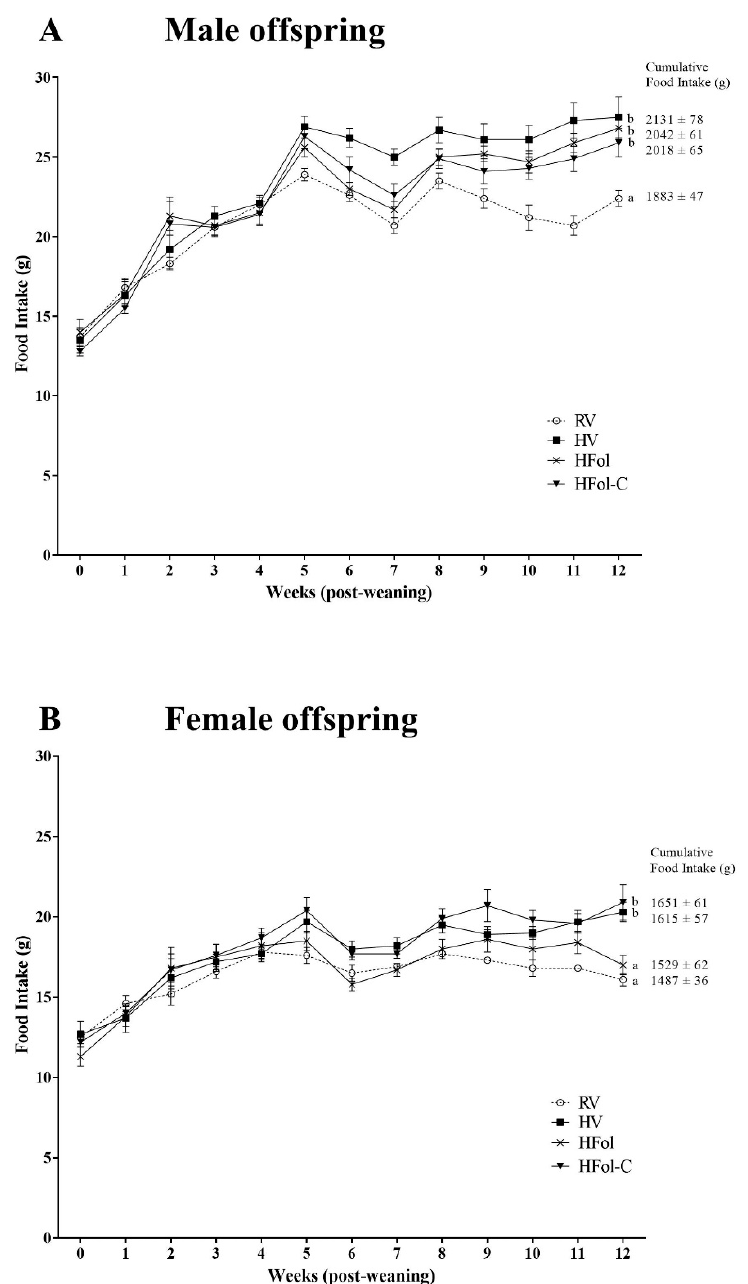
Figure 3. Food intake, in grams, in ( A ) male and ( B ) female offspring from 0-12 weeks post-wean- ing. Diet abbreviations: RV, recommended vitamin; HV, high multivitamin; HFol, high folic acid 0.0001, Diet*Time p = 0.002. ( B ) Diet p = 0.001, Time p < 0.0001, Diet*Time p = 0.04. Superscripts Diet ∗ Time p = 0.002. ( B ) Diet p = 0.001, Time p < 0.0001, Diet ∗ Time p = 0.04. Superscripts